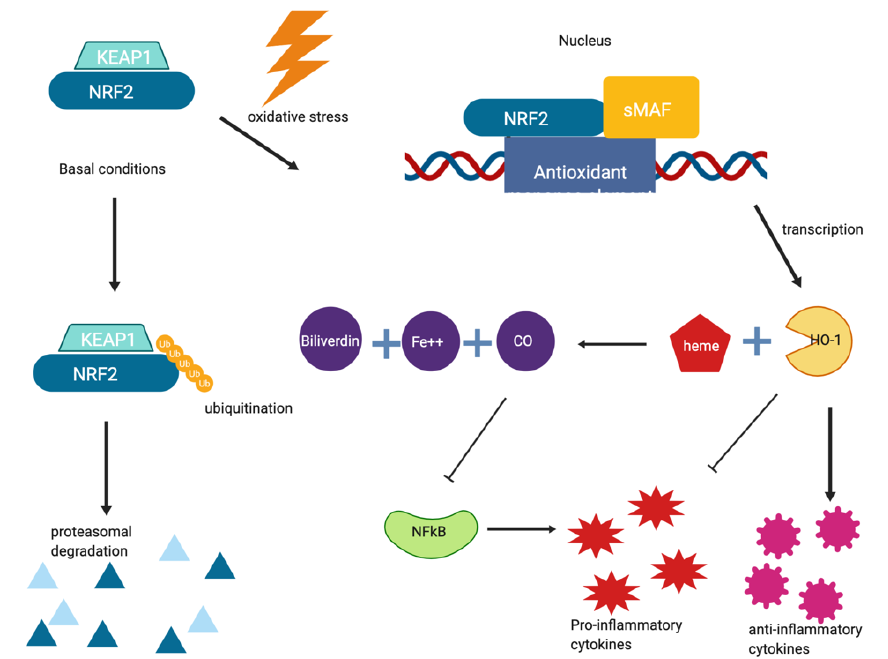
Figure 5. NRF2 signaling and inflammation. Under basal conditions, NRF2 is bound to its repressor, KEAP1 and ultimately degraded by the proteasome following ubiquitination. However, under oxidative stress, free NRF2 translocates to the nucleus and dimerizes with small MAF family proteins. This complex binds to and promotes the expression of genes with an antioxidant response element, such as HO-1. HO-1 directly inhibits pro-inflammatory cytokines while upregulating anti-inflammatory cytokines as well as catalyzing the breakdown of heme into carbon monoxide, free iron, and biliverdin. Carbon monoxide is an inhibitor of the NFκB pathway, resulting in an overall decrease of pro-inflammatory cytokines. The image in Figure 5 was created using BioRender.com.